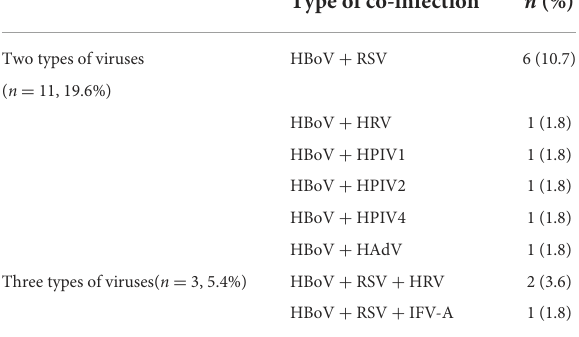
TABLE 3 The type of HBoV coinfected with other